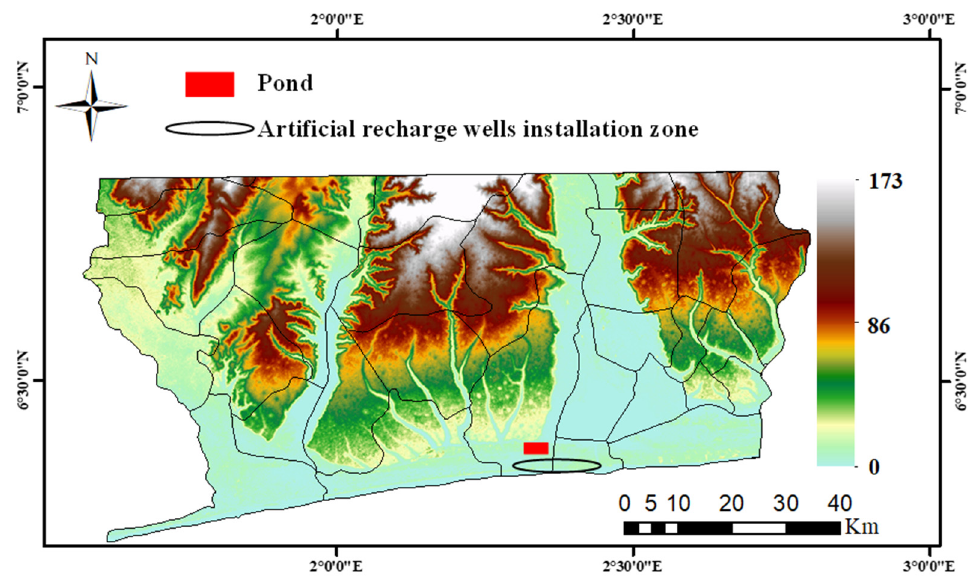
Figure 8. Recharge wells and pond cells location for the simulation. Table 3. Impact of countermeasures on SWI area variation.